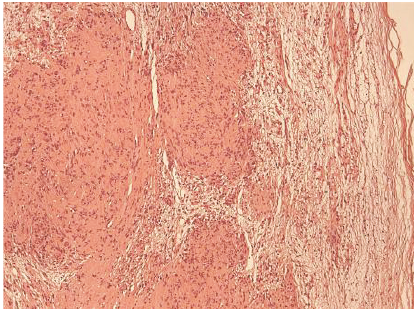
Figure 5: Small plexiform nodules with elongated, spindle-shaped tumor cells with no atypia or mitoses: Antoni A (left). Haphazard, scarcecellulararrangementinaloosestroma:AntoniB(right).E&H stain x10.